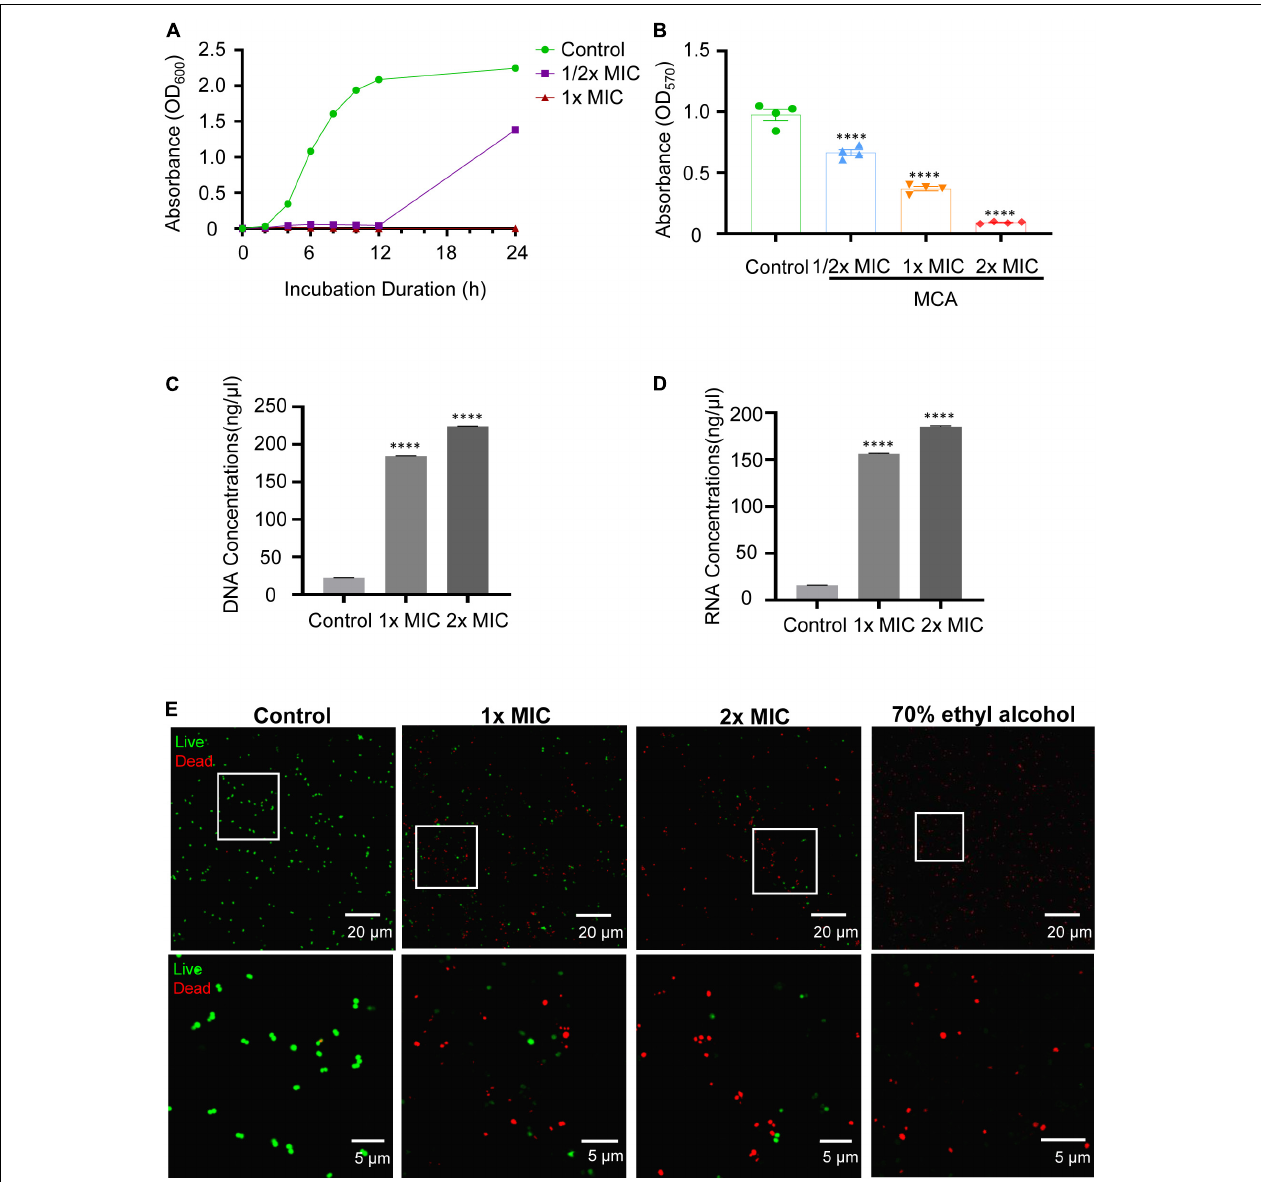
FIGURE 1 | MCA inhibited the growth and biofilm formation, and increased the permeability of MRSE. (A) MCA inhibited the proliferation of MRSE in a dose-dependent way. MRSE in the exponential growth phase was treated with MCA at 0, 1/2 × MIC, and 1 × MIC for the indicated time, respectively, while 0.1% EtOH was used as the vehicle control. The proliferation of MRSE was measured by monitoring the absorbance at 600 nm (OD600). (B) MRSE inhibited biofilm formation of MRSE. MRSE in the exponential growth phase was treated with MCA at the indicated concentration for 24 h, and the biofilm formation was measured by monitoring the absorbance at 570 nm (OD570) after CV staining. (C,D) MCA induced the leakage of DNA and RNA from MRSE. MRSE in the exponential growth phase was treated with MCA at 1 × MIC and 2 × MIC for 6 h, while the 0.1% EtOH was used as vehicle control. The leakages of DNA and RNA were quantified by measuring the absorbance at 260 and 230 nm using a NanoDrop spectrophotometer. The pooled data are presented as mean ± SEM of at least three independent experiments. ∗ p < 0.05, ∗∗ p < 0.01, ∗∗∗ p < 0.001, ∗∗∗∗ p < 0.0001. (E) MCA decreased the viability of MRSE. MRSE was treated with MCA at the indicated concentration for 6 h and then stained with SYTO-9/PI. The images were obtained by confocal microscopy, and the green and red fluorescence indicate the live and dead bacteria, respectively. The highlighted regions are magnified in the lower panel. The representative images were selected from at least three independent